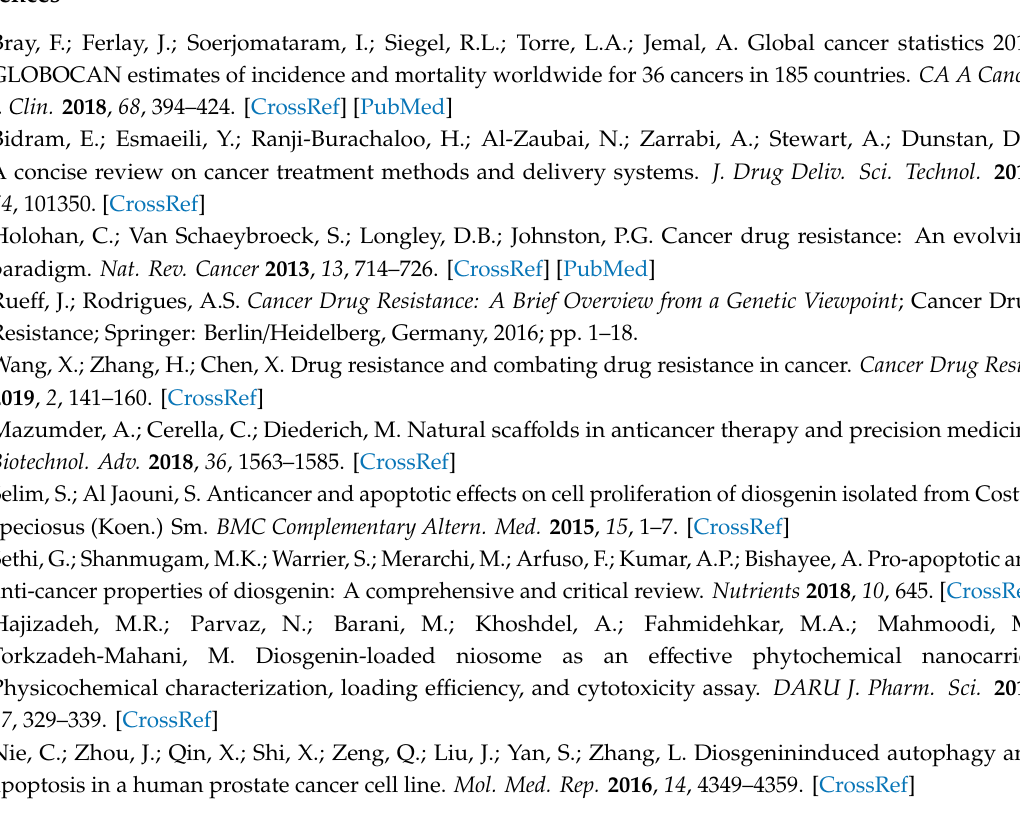
Figure S1: The molecular structure of the polymer (PGMD) as investigated by 1H NMR, Figure S2: FTIR of PGMD polymer, Figure S3: Represents the Size and PDI analysis of PGMD-DG 6:4 NP, Figure S4: Represents the Size and PDI analysis of PGMD-DG 7:3 NP, Figure S5: Represents the Size and PDI analysis of PGMD 6:4 NP, Figure S6: Represents the Size and PDI analysis of PGMD 7:3